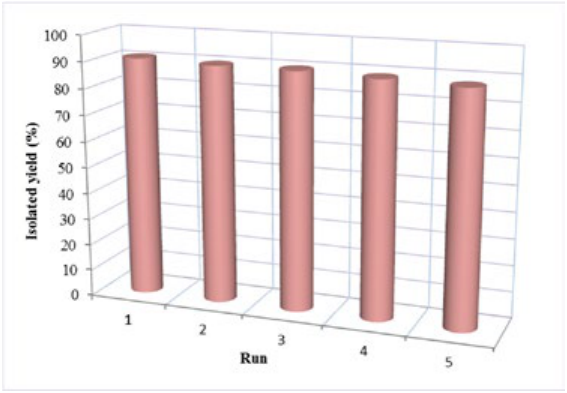
Fig. 2. Reusability of {[2,2'-BPyH][C(CN) 3 ] 2 } in the synthesis of biscoumarin for the model reaction in 10 min.